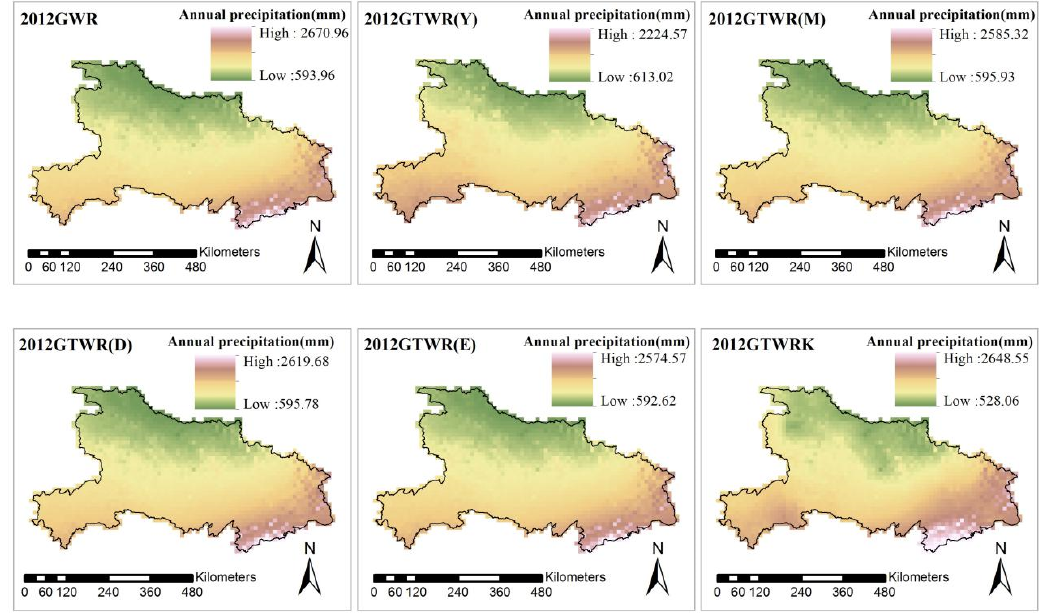
Figure 9. The interpolation distribution maps for GWR, GTWR(Y), GTWR(M), GTWR(D), and GTWR(E) corresponding to 2012.